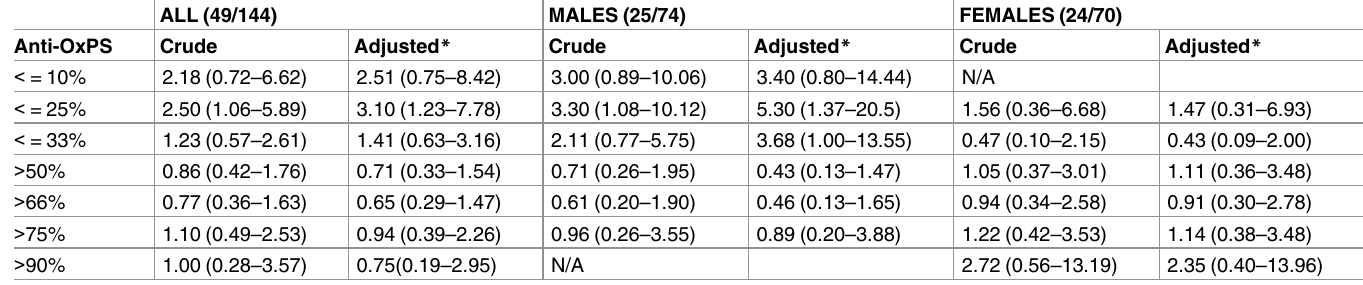
Table 6. Association between levels of IgM anti-OxPS and risk for stroke, among all participants and men and women separately. Both cases and controls were includedas the basis for divisioninto seven percentiles where the one studiedis comparedto the rest. ALL (49/144)